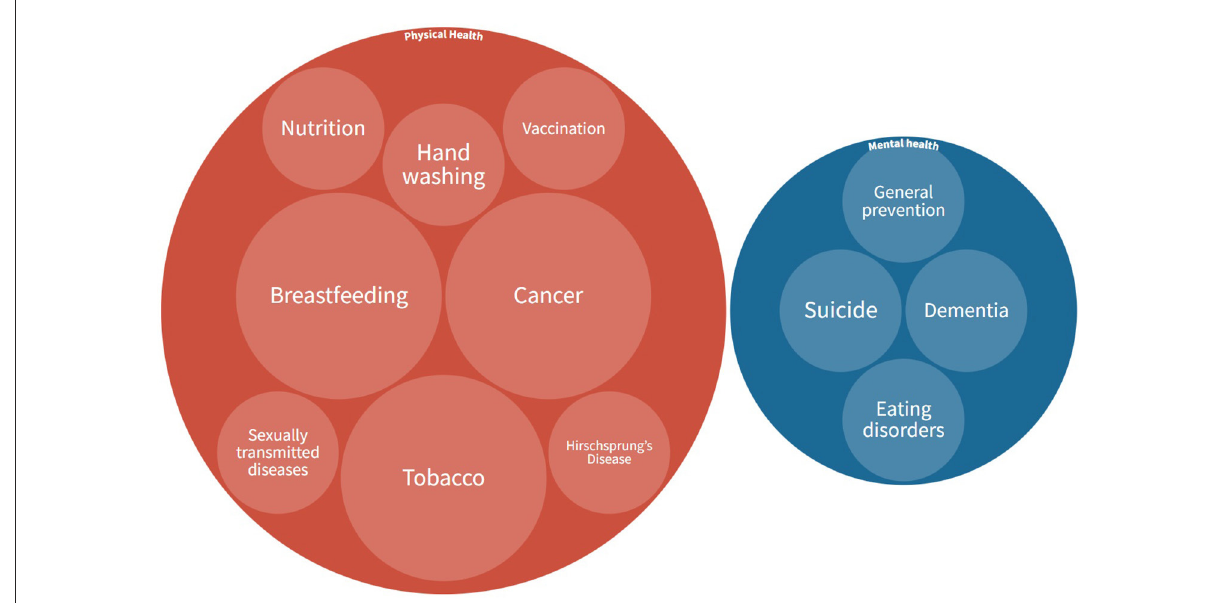
FIGURE3 Distribution of the themes addressed by the health campaigns evaluated in the selected